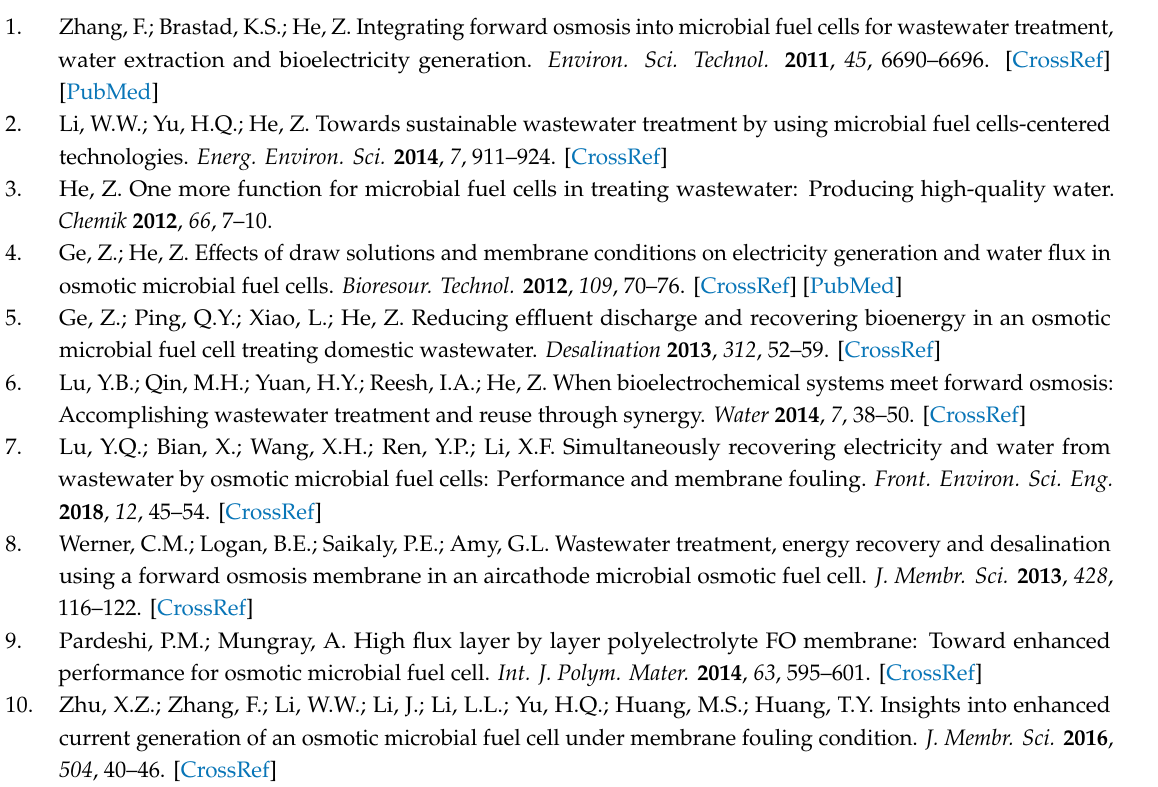
Figure S1: Schematic diagram of the OsMFC; Figure S2: (a) AFM micrographs and (b) contact angle micrographs of (1) the pristine and (2) the modified active layer of TFC–FO membranes; Figure S3: Water flux of the pristine and modified TFC–FO membranes determined by the FO–Cell using synthetic wastewater as the feed solution and 1 M NaCl solution as the draw solution; Figure S4: CLSM images of bacteria attached to the surface of (a) the pristine and (b) the modified TFC-FO membranes; Figure S5: Integrated CLSM images of polysaccharides (blue), proteins (green) and microorganisms (red) in the biofouling layer of (a) the pristine and (b) the modified TFC–FO membranes; Table S1: Composition of the synthetic wastewater; Table S2: EDX analyses of the pristine and modified active layer of TFC–FO membranes; Table S3: Properties of the foulants collected from the fouled pristine and modified TFC–FO membranes; Table S4: Biovolume and mean thickness of the pristine and modified TFC–FO